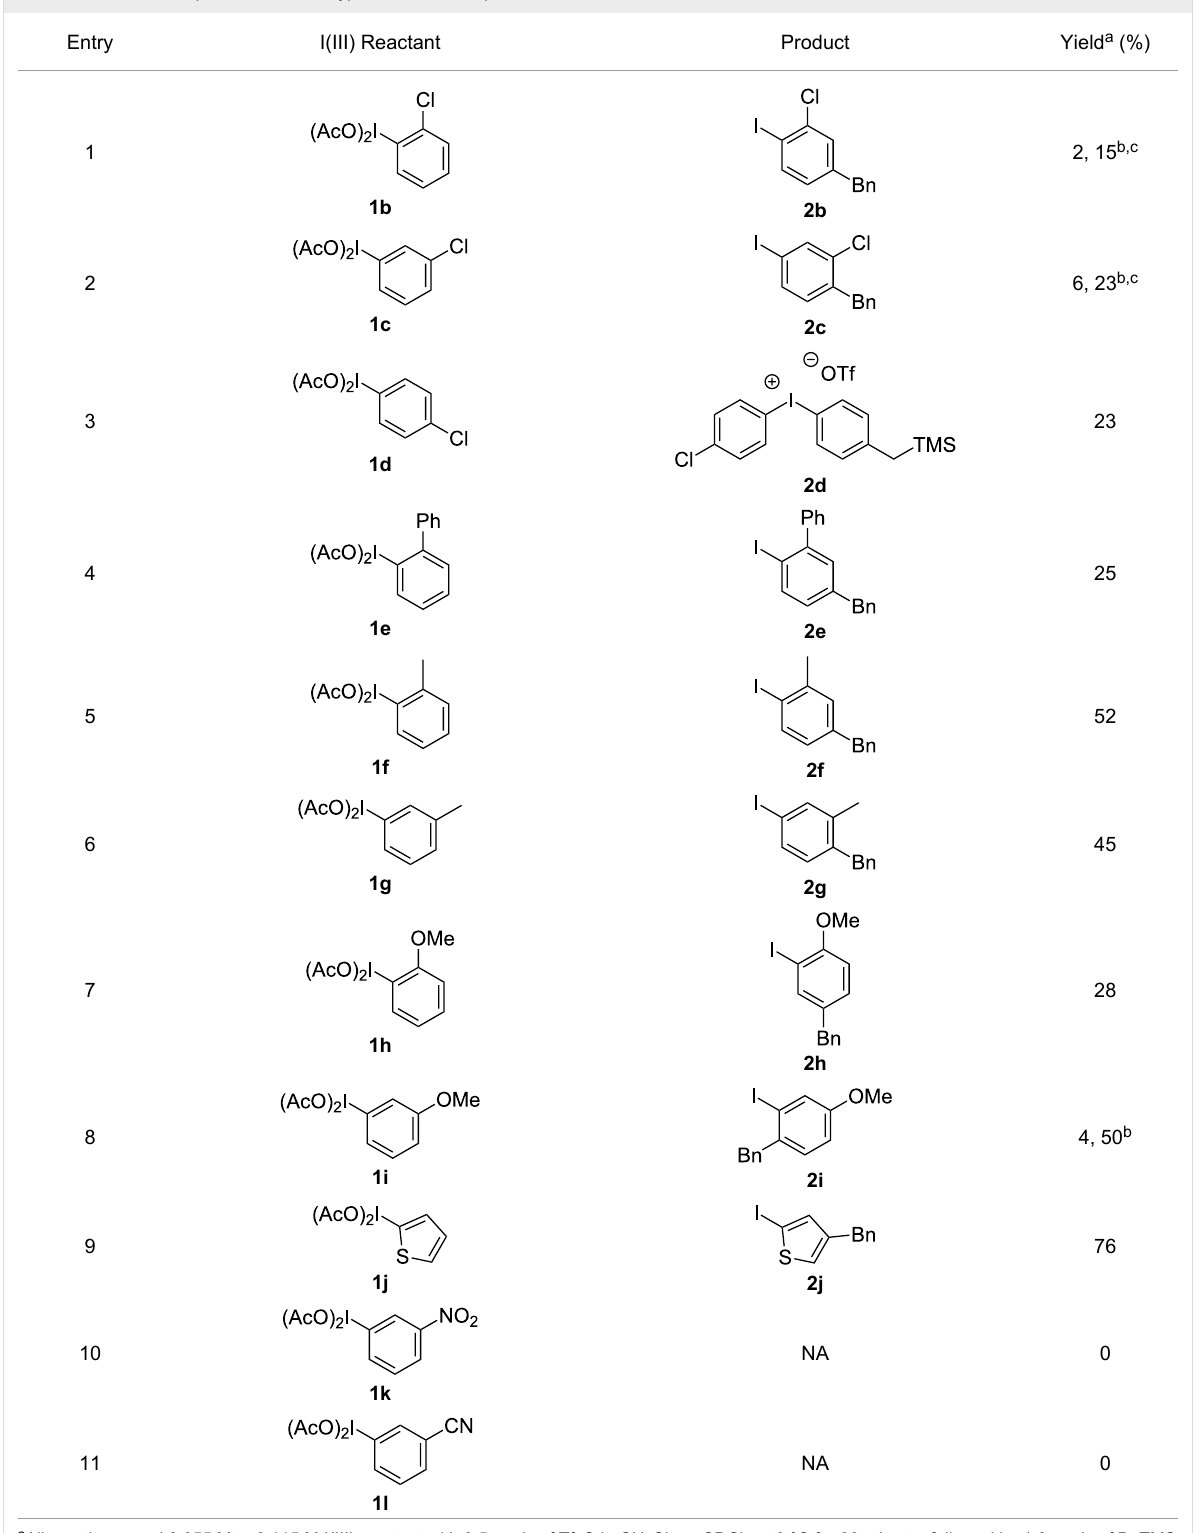
Table 2: Substrate scope of substituted hypervalent iodine